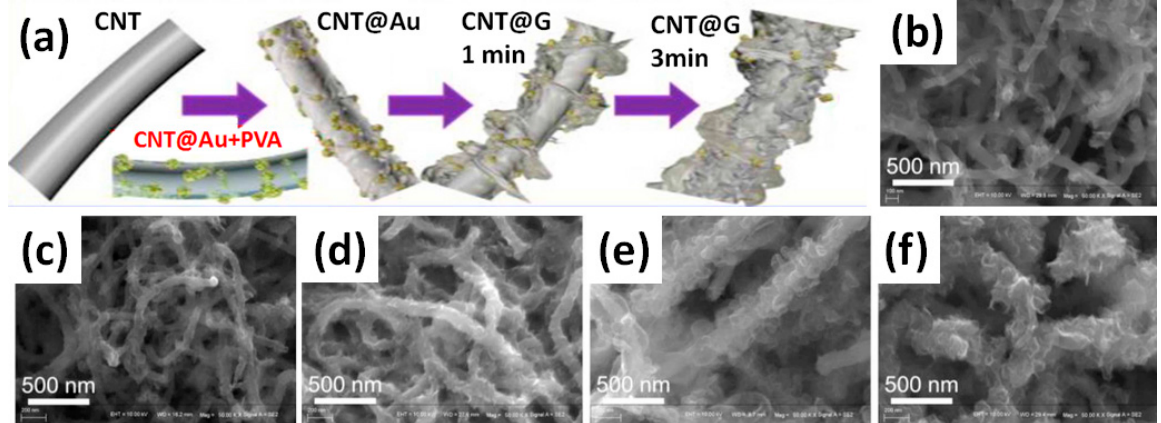
Figure 18. Schematic diagram of formation of CNT@Au composite with Au catalyst ( a ) and its SEM images after growth periods of about 3 min ( b ), 5 min ( c ), 6 min ( d ), 7 min ( e ) and 10 min ( f ) (Reproduced with permission of [46]. Copyright Elsevier, 2019).